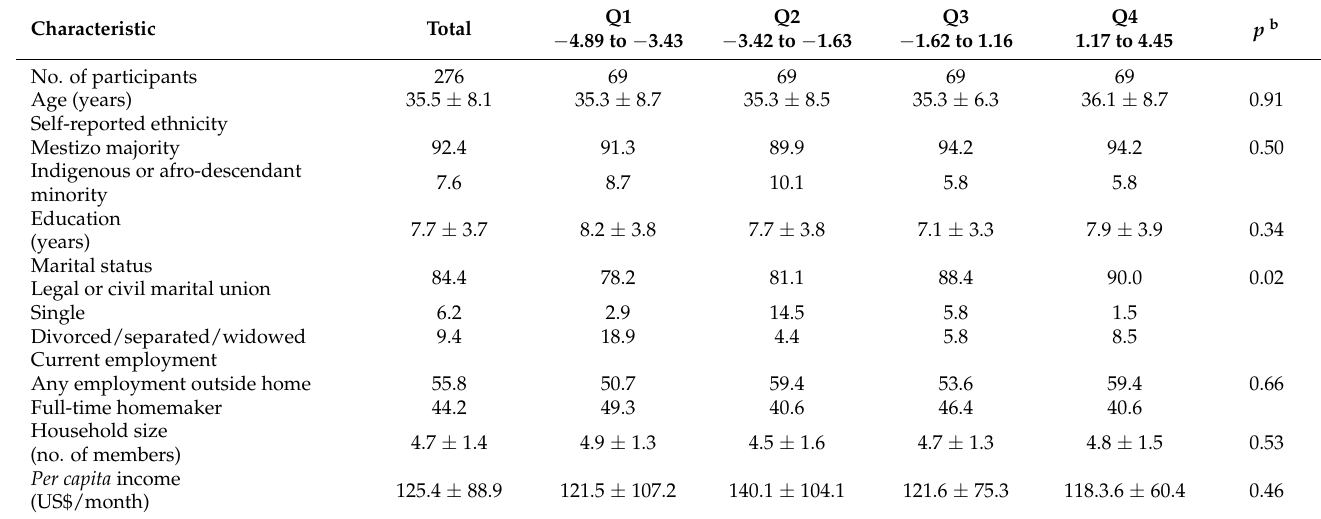
Table 1. Individual, household, and neighborhood characteristics of participants across quartiles of E-DII a .